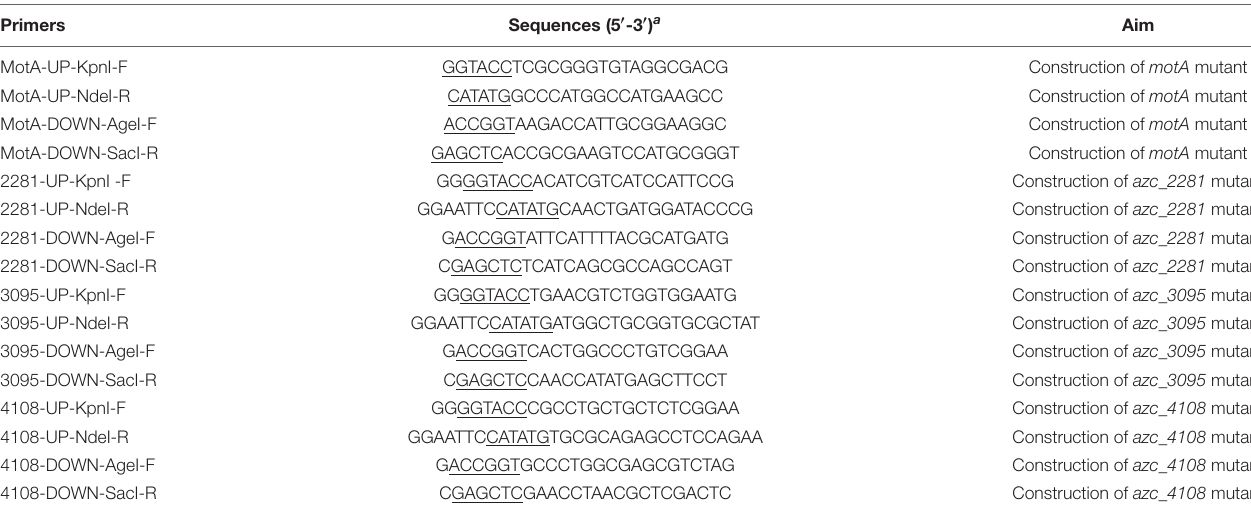
TABLE 2 | PCR primers used in this